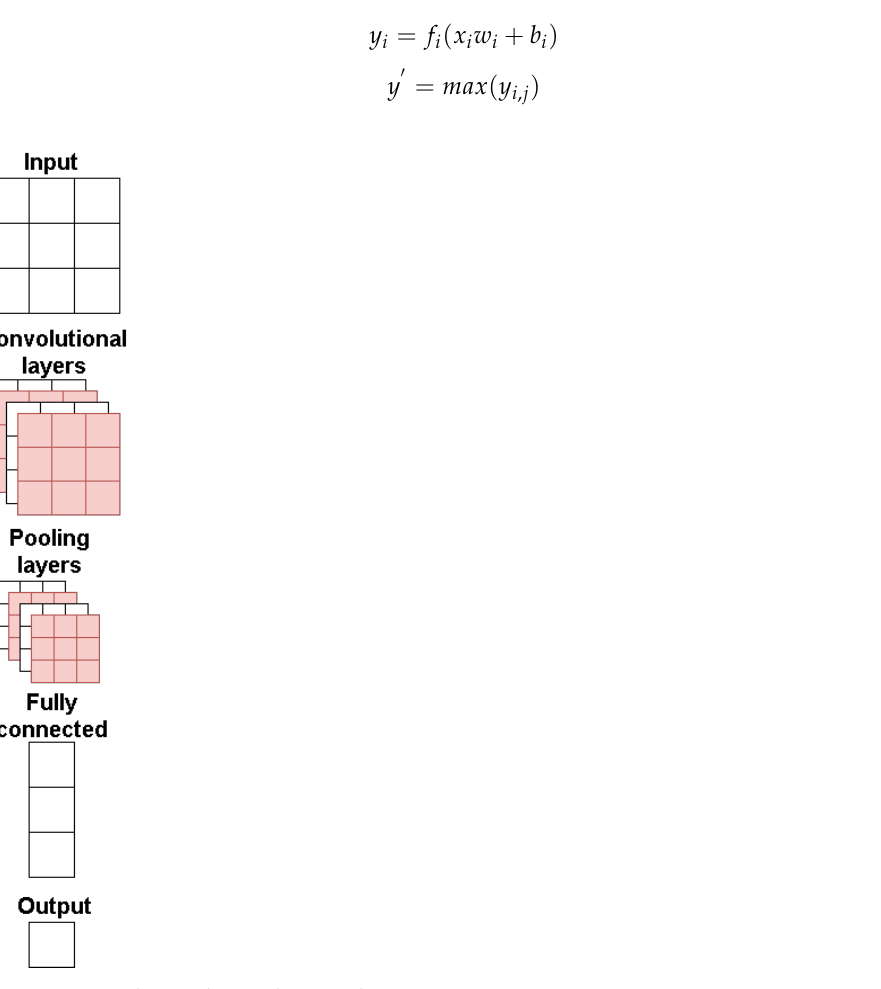
Figure 3. Convolutional neural network